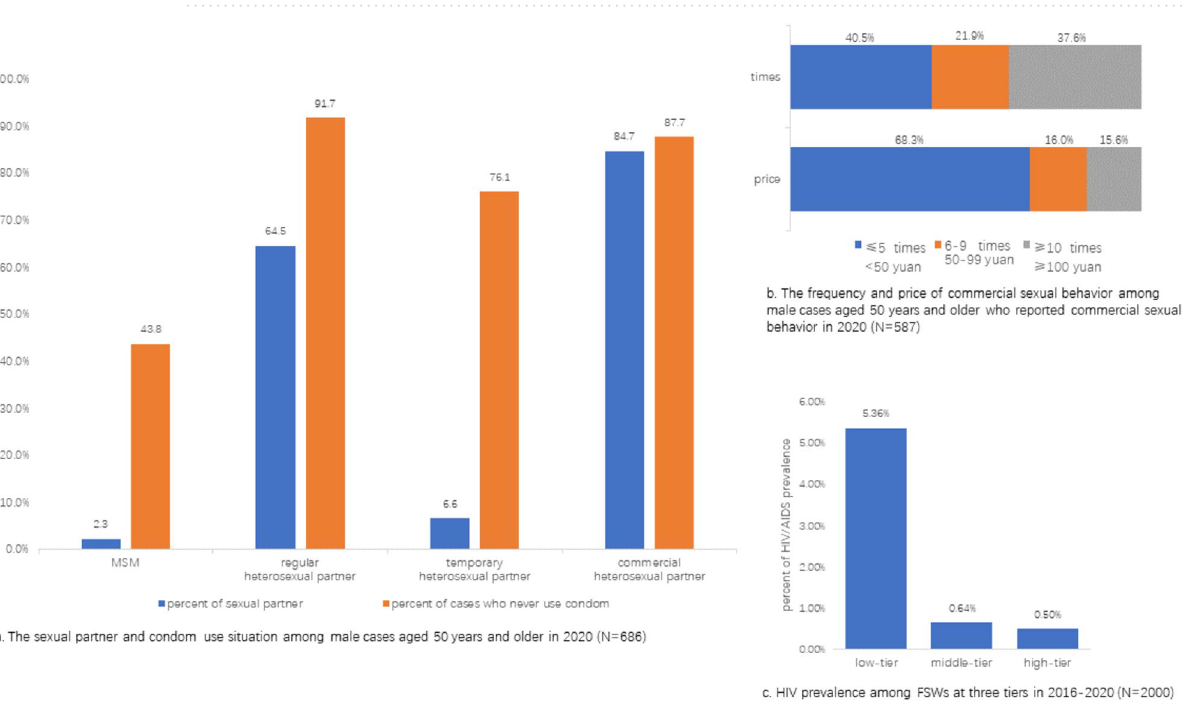
Figure 2. Sexual behaviors in HIV/AIDs male cases aged 50 years and older and the details of their commercial sexual